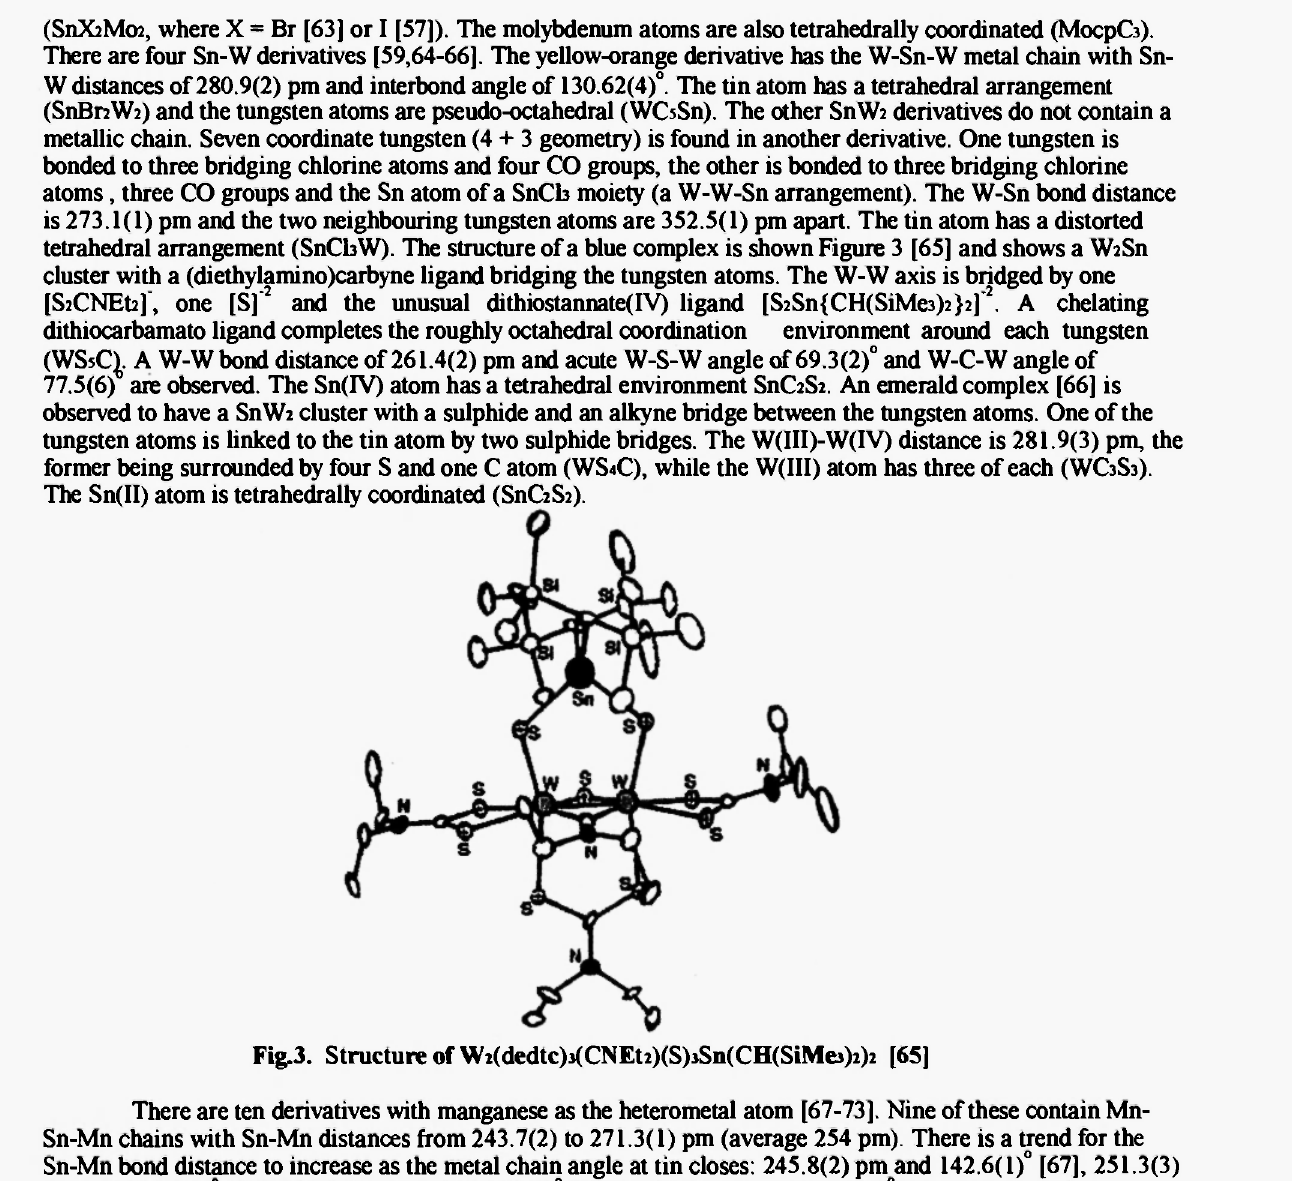
Fig.3. Structure of Wi (dedtc )i(CNEt2 )(S)iSn (CH (SiMei )2)2